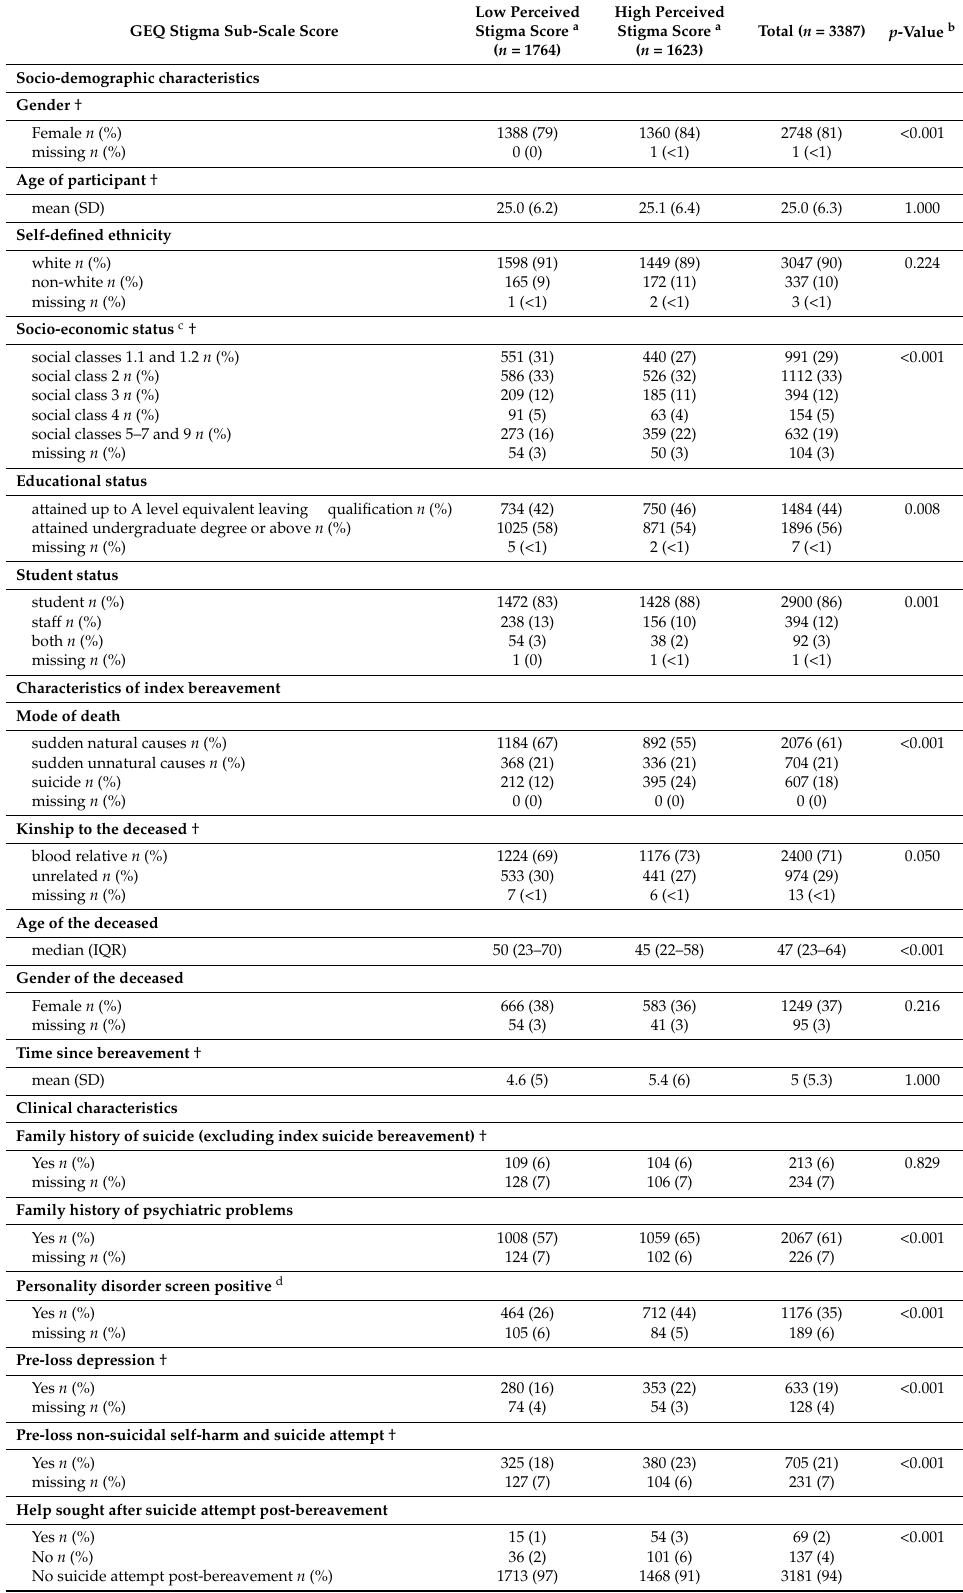
Table 1. Characteristics of participants by high versus low perceived stigma